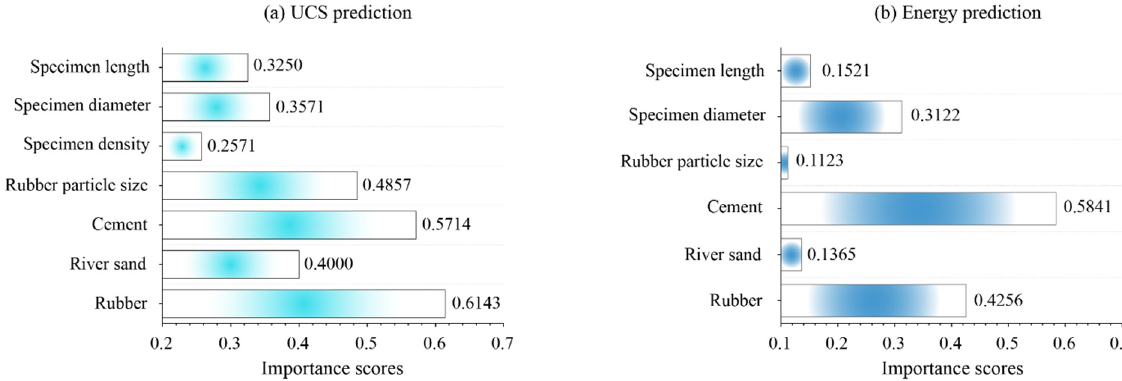
Figure 10. The illustration of sensitive analysis results based the LHSPOA-RF